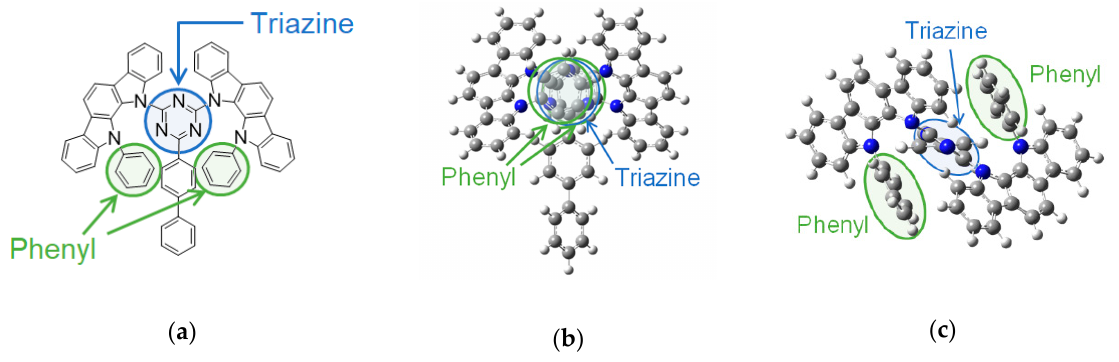
Figure 7. PIC–TRZ: ( a ) molecular structure; ( b ) optimized molecular structure (from the side); and ( c ) optimized molecular structure (from the top).